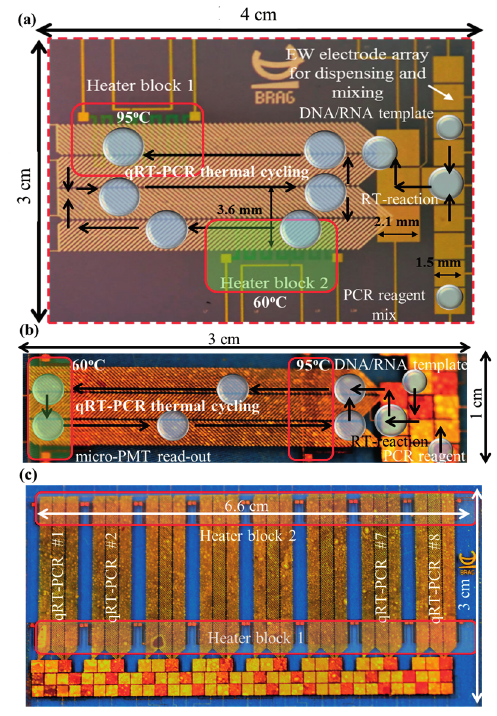
Figure 1. ( a ) Photomicrographs of ( a ) the spiral droplet-dielectrophoresis (D-DEP)